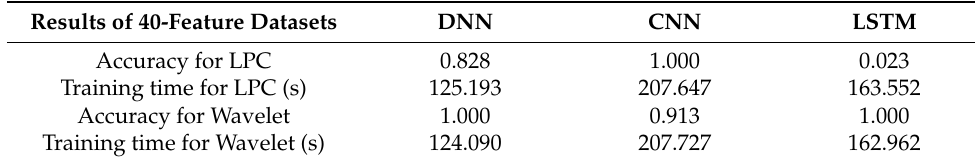
Table 3. Results with three deep learning structures of 40-feature datasets.